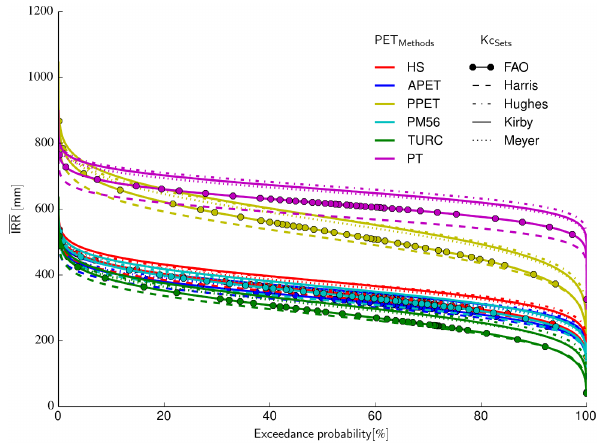
Figure 4. Cumulative density function of equally weighted (IRR ) and REA-weighted (IRR REA ) average irrigation water require- ment for wheat during the growing season. Averages have been calculated for each cropping area ( n = 3969 = 100%) for the pe- riod 1986–2006. Colours indicate the predicted root mean square error (RMSE) of the ensemble of ET o methods and K c sets (APET: areal potential evapotranspiration; PM56: FAO56 Penman– Monteith; HS: Hargreaves–Samani; PPET: point potential evapo- transpiration; PT: Priestly–Taylor; TURC: Turc). Table 3. Average equally weighted irrigation water requirement (IRR) (mm) during the growing season of wheat in all cells ( n = 3969) of the MDB grouped by ET o methods and K c sets over the period 1986–2006 (APET: areal potential evapotranspiration; PM56: FAO56 Penman–Monteith; HS: Hargreaves–Samani; PPET: point potential evapotranspiration; PT: Priestly–Taylor;